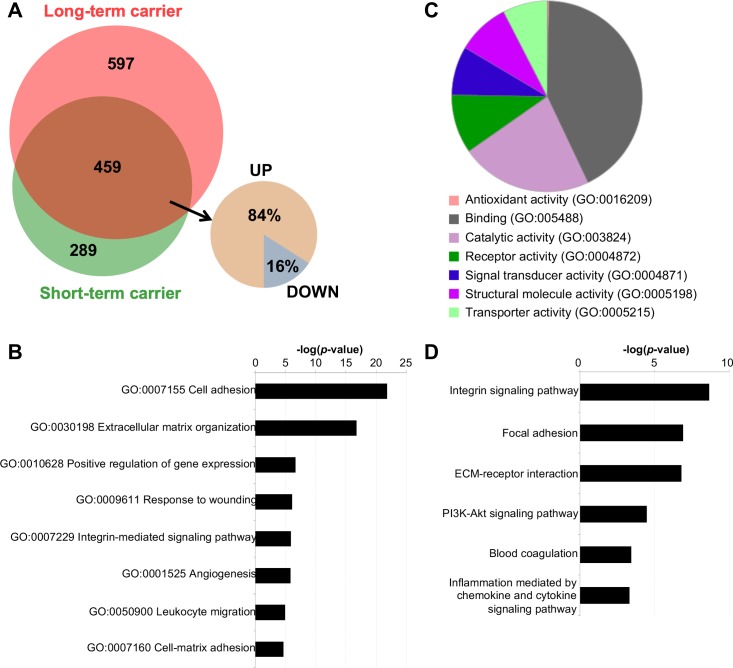
Differential gene expression profile in the ampullae of long-term (n = 3) and short-term (n = 6) EAV carrier stallions compared to the naïve group (n = 3).(A) The Venn diagram depicts the differentially expressed genes (DEGs) common between long-term and short-term carrier stallions, with a clear majority being upregulated. (B and C) GO analysis (biological process and molecular function) of commonly upregulated genes between long-term and short-term carrier stallions reveal involvement in biological processes associated with cell adhesion, extracellular matrix organization, response to wounding, integrin signaling, among others, with a high proportion of genes presenting binding and catalytic activities. (D) Significant pathways associated with commonly upregulated genes.